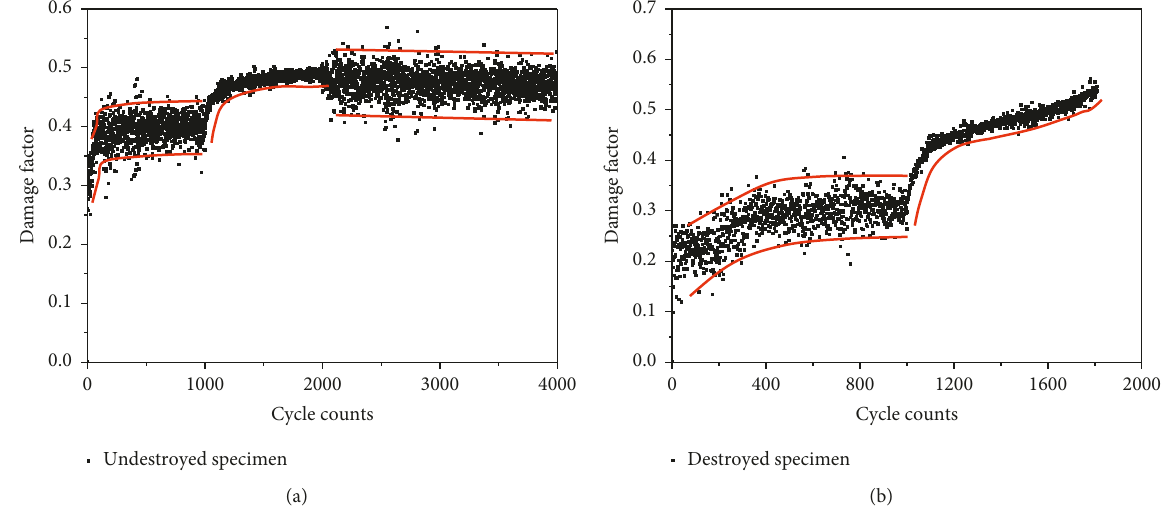
Figure 10: Relationship between the damage variable and the vibration number of the coal sample. (a) Disturbance from 0.5‰ to 1‰ and then to 0.5‰. (b) Disturbance from 0.5‰ to 1‰ and then to